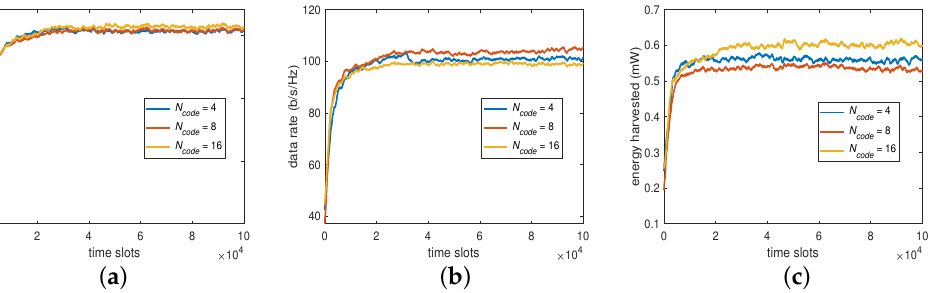
Figure 5. System performance by varying N code : ( a ) utility, ( b ) data rate, and ( c ) harvested